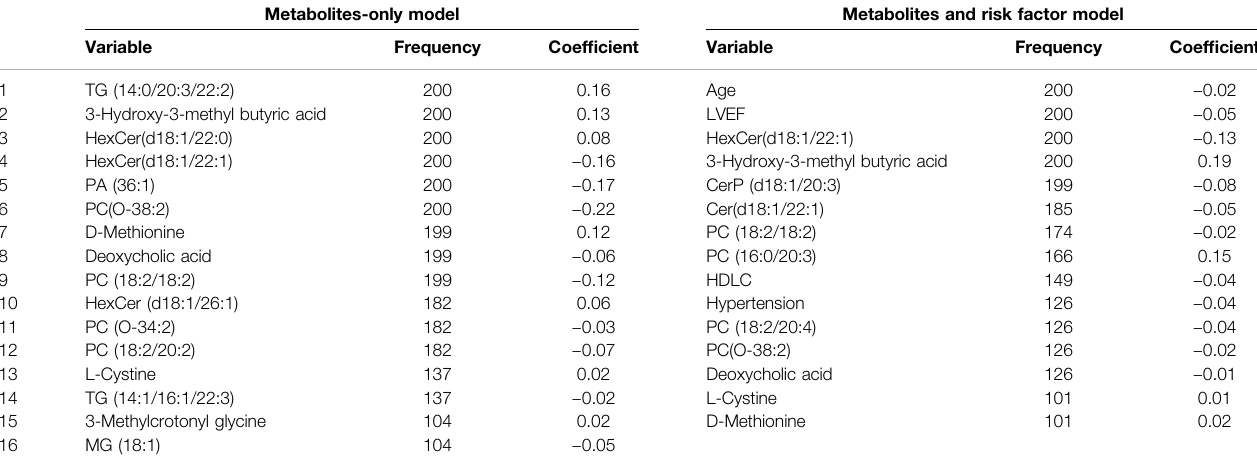
TABLE 3 | Feature inclusion frequency using LASSO based feature selection for MI (vs. UA). Metabolites-only model Metabolites and risk factor model